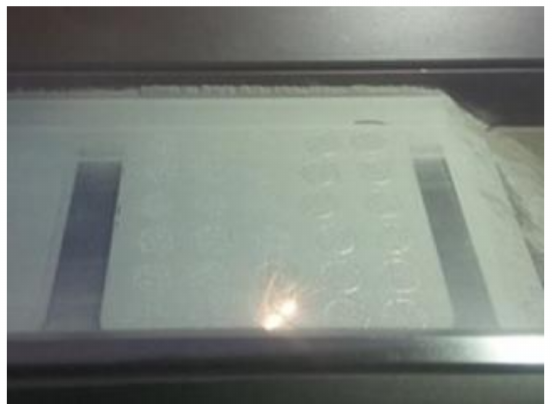
Figure 5. Process of additive manufacturing of testing Ti6Al4V